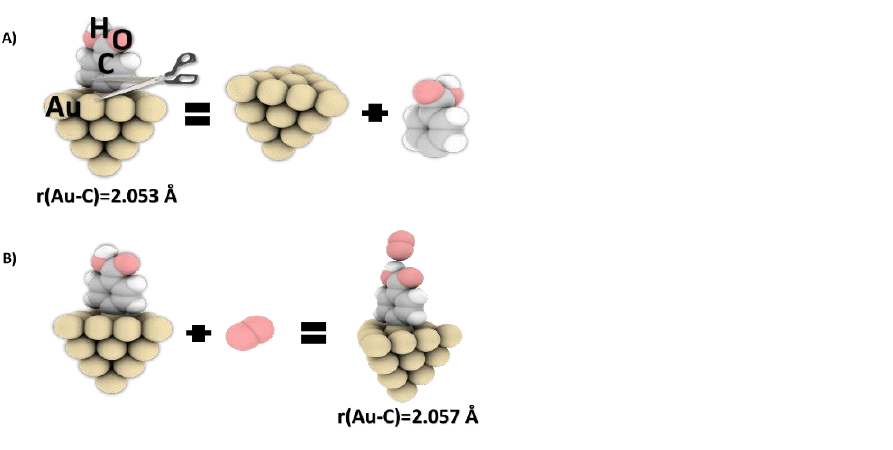
Figure 7. ( A ) Bond dissociation energies (calculated by DFT) for a Au cluster with grafted carboxyphenyl moieties and ( B ) optimized structures for the interaction of oxygen molecules with the Au-PhCOOH system (level of theory: DFT/B3LYP/aug-cc-pvdz for C, H, and O atoms and LanL2DZ basis set for Au atoms).